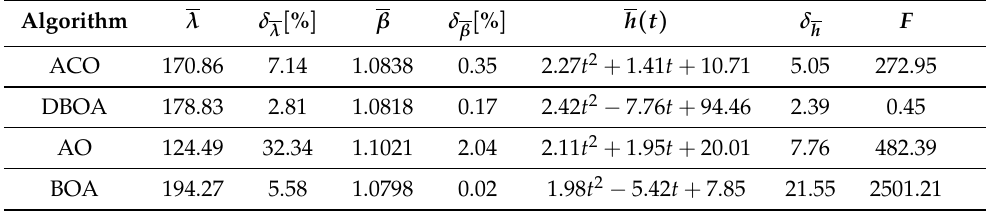
Table 1. Results of calculations ( λ —identified value of thermal conductivity coefficient; β —identified value of derivative order; h ( t ) —identified value of heat transfer function; δ —the relative error of reconstruction; F —the value of the fitness function).